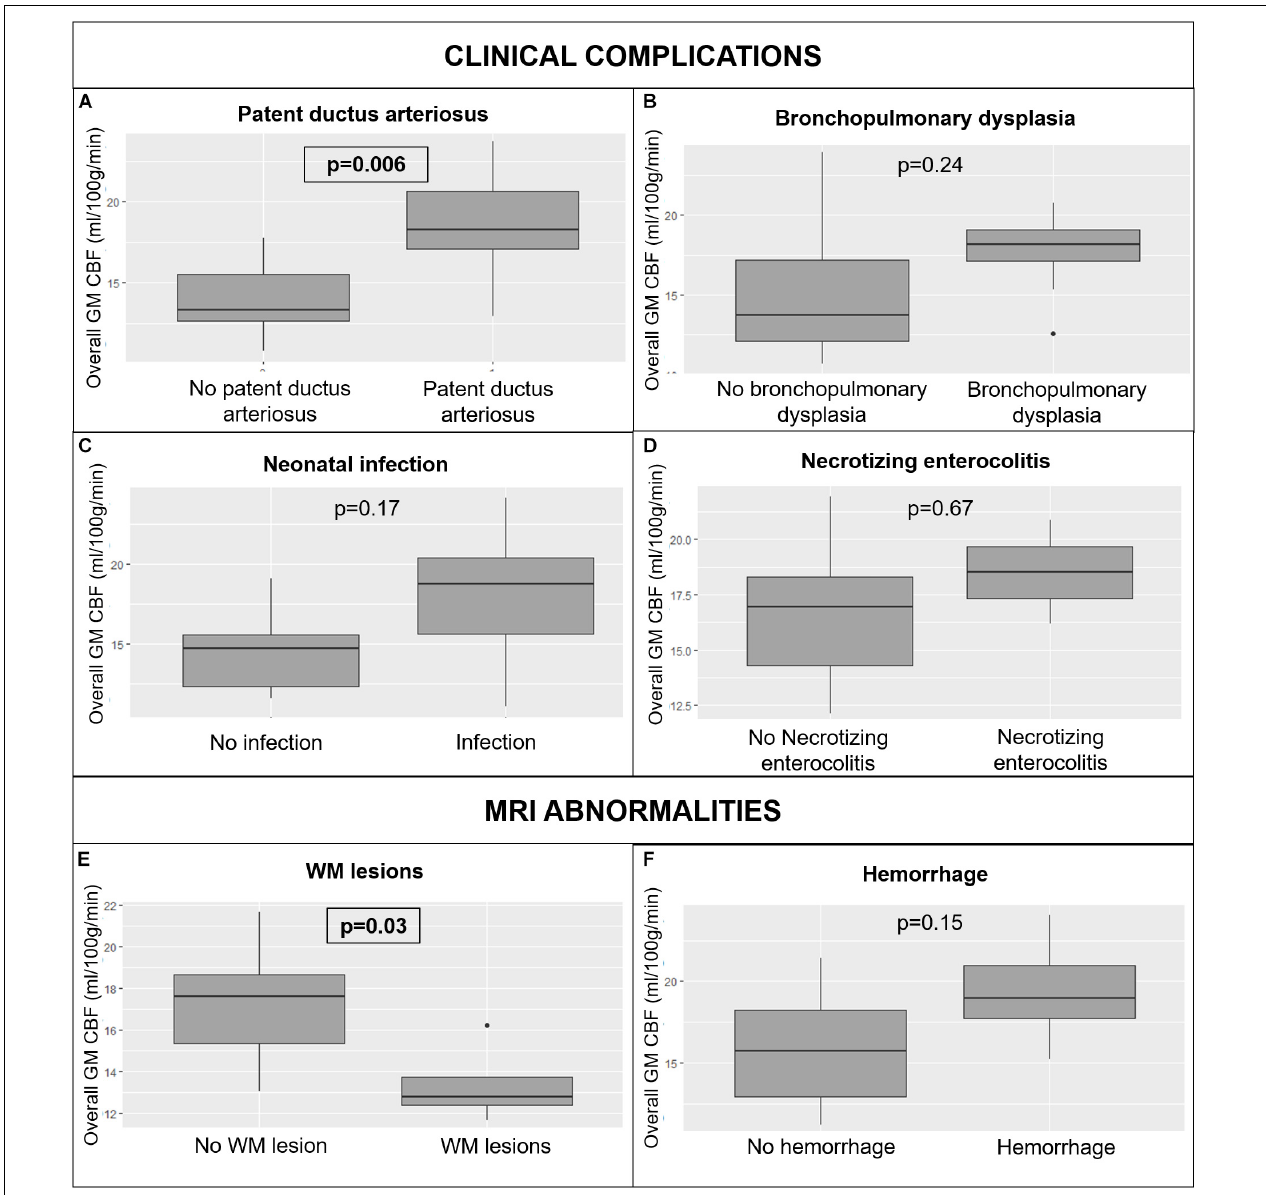
FIGURE 7 | Variations in whole brain GM CBF in preterm infants according to clinical complications: patent ductus arteriosus (A) , bronchopulmonary dysplasia (B) , neonatal infection (C) , and necrotizing enterocolitis (D) ; and MRI abnormalities: WM lesions (E) and hemorrhage (F) . CBF: cerebral blood flow, MRI: magnetic resonance imaging, WM: white matter. The significant p -values are in bold characters within a square frame.